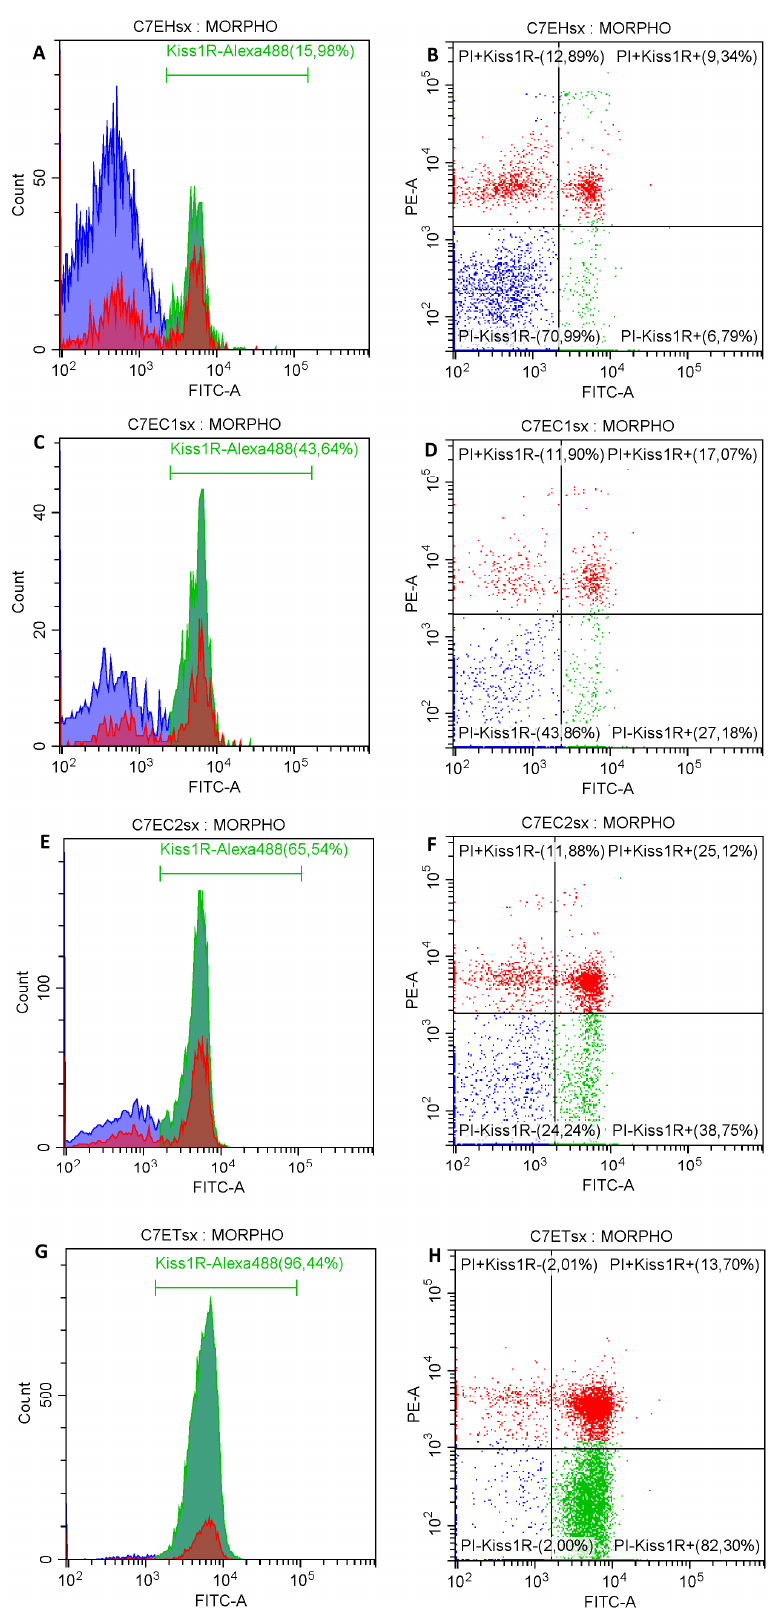
Figure 3. Exemplificative histograms and plots of the Kiss1R surface expression on spermatozoa with membrane integrity in the epididymal head ( A , B , respectively), the cranial portion of the epididymal corpus ( C , D ), the caudal portion of the epididymal corpus ( E , F ), and epididymal tail ( G , H